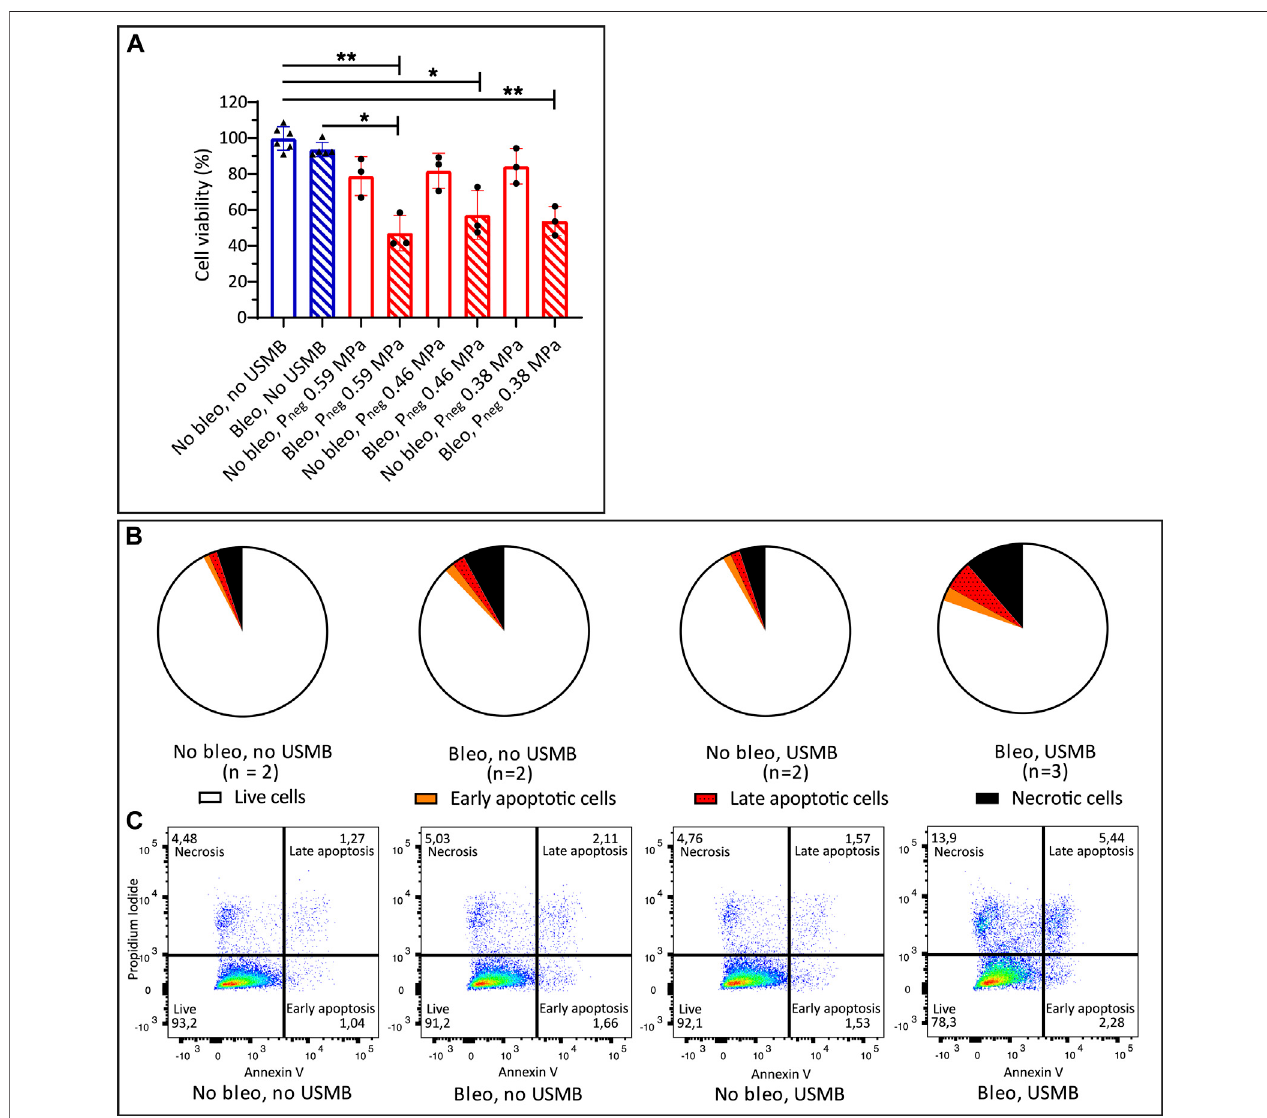
FIGURE6| Cellviabilityafterbleomycin ± USMBusingtheclinicalUSsystemwithS5-1probe (A) Bleomycin10 μ g/mlorNaCl0.9%with(red,circles)andwithout(blue, triangles) USMB at three pressures (MI 0.6, 0.5 and 0.4). Symbols indicate individual measurements and bars indicate mean and SD ( n ≥ 3). * p < 0.05 ** p < 0.01 (B) Flow cytometry analysis of Propidium Iodide and Annexin V staining 48 h after bleomycin 10 μ g/ml or NaCl 0.9% with or without USMB at P neg 0.59 MPa (MI 0.6), pie charts represent the mean of the samples with n (cid:1) 2 or (for bleomycin + USMB samples) n (cid:1) 3. (C) Representative dot plots of fl ow cytometry analysis shown in (B) . More apoptosisandnecrosiswasobservedafterbleomycin+USMB.Bleo:bleomycin;MI:MechanicalIndex;P neg :Peaknegativepressure;USMB:ultrasoundandmicrobubbles.